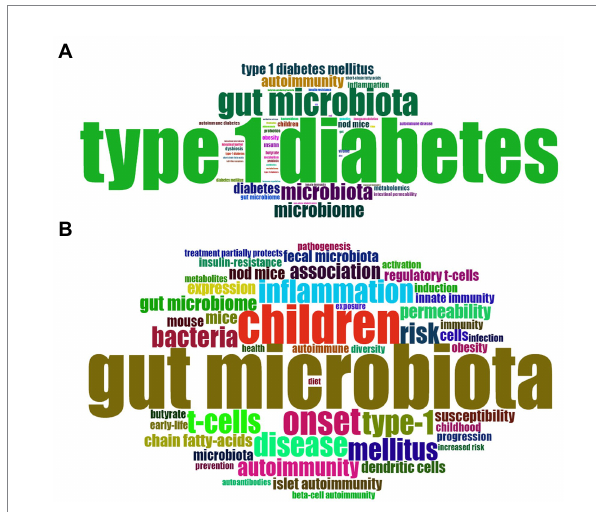
FIGURE 7 Distribution of the top 50 (A) Author Keywords and (B) Keywords